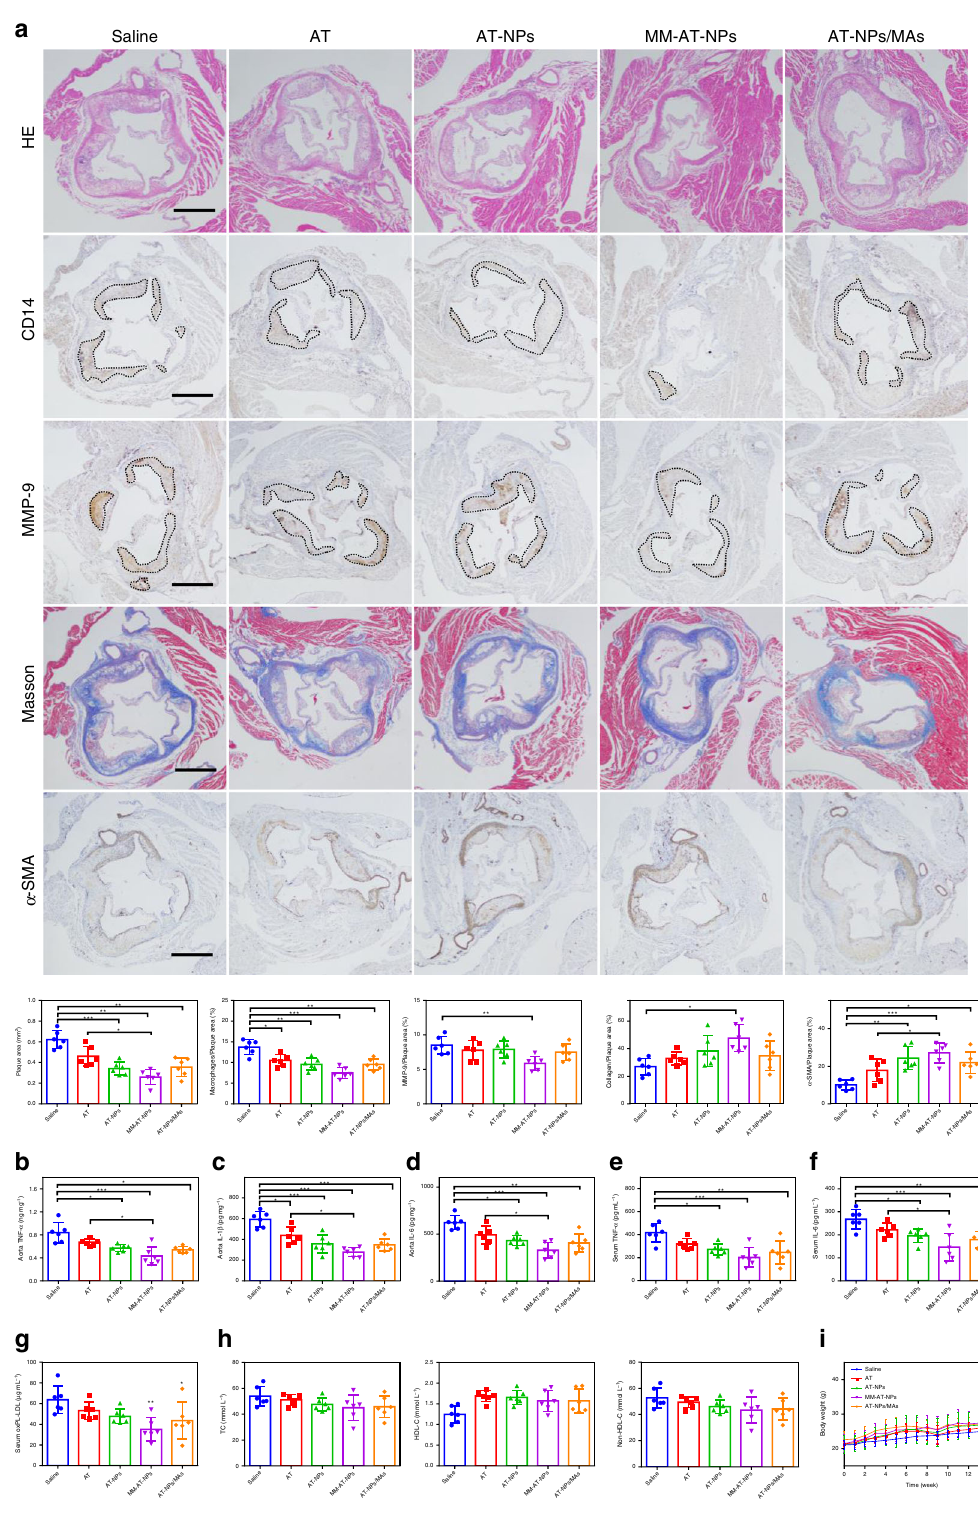
Fig. 4 MM-AT-NPs ameliorated plaque and in fl ammation in an atherosclerotic mouse model. a Representative photographs and quantitative analysis of aorta root sections stained by H&E, CD14 antibody, MMP-9 antibody, Masson ’ s trichrome, and α -SMA antibody ( n = 6). Scale bar: 500 μ m. b – d The levels of TNF- α , IL-1 β , and IL-6 in aorta tissues collected from atherosclerotic mice after treatment with various formulations (saline, AT, AT-NPs, MM-AT-NPs, and AT-NPs/MAs) at a dose of 2 mg kg − 1 AT per week ( n = 6). e – g The levels of TNF- α , IL-6 and oxPL-LDL in blood serum ( n = 6). h The levels of TC, HDL-C, and Non-HDL-C in the blood serum ( n = 6). i The changes of body weight in atherosclerotic mice treated with various formulations (saline, AT, AT-NPs, MM-AT-NPs, and AT-NPs/MAs) ( n = 7). All data were presented as mean ± s.d. Statistical analysis was conducted using one-way ANOVA. * P ≤ 0.05, ** P ≤ 0.01, and *** P ≤ 0.001. Source data are provided as a Source Data fi